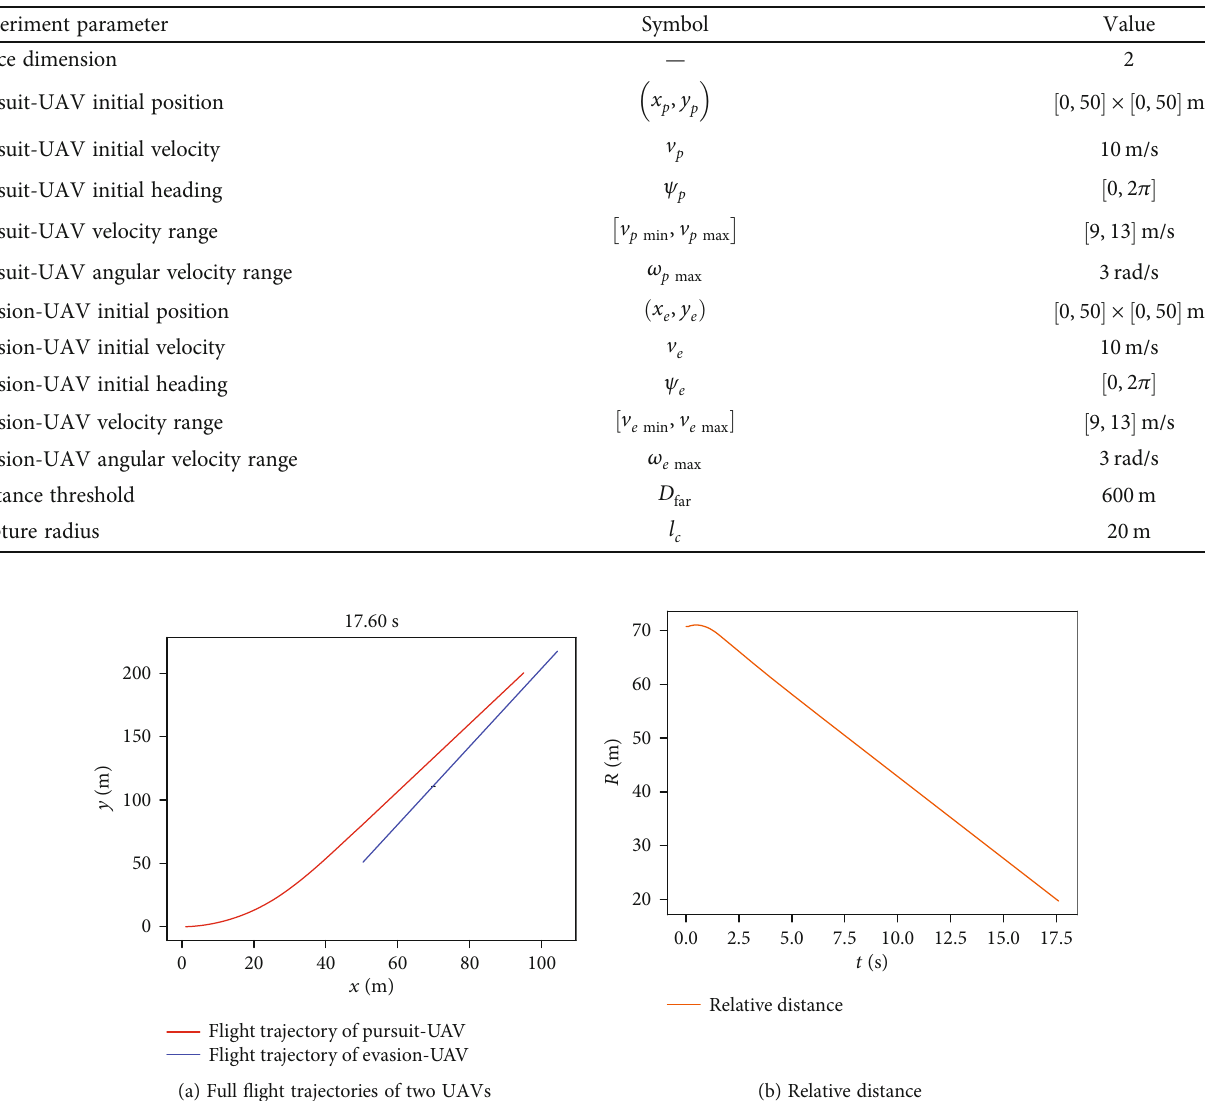
Table 2: Table of experiment parameters.